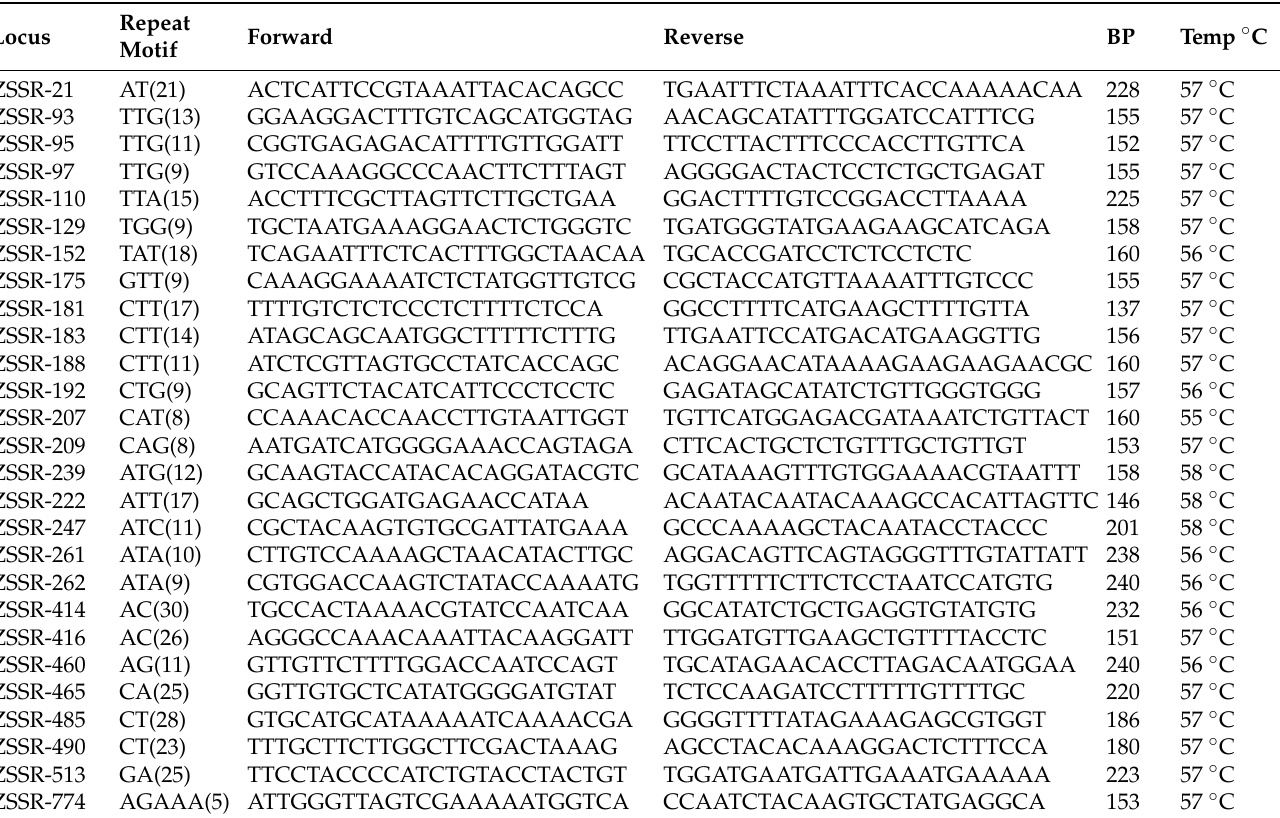
Table 1. Description of 27 SSR pair primes used for Z. nummularia collected from different geographi- cal regions KP,